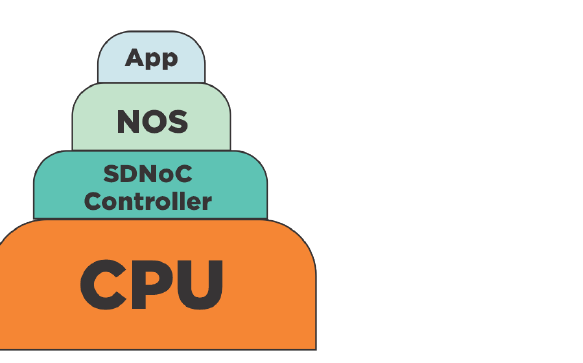
Figure 4. Software architecture and components in a layered SDNoC appraoch.